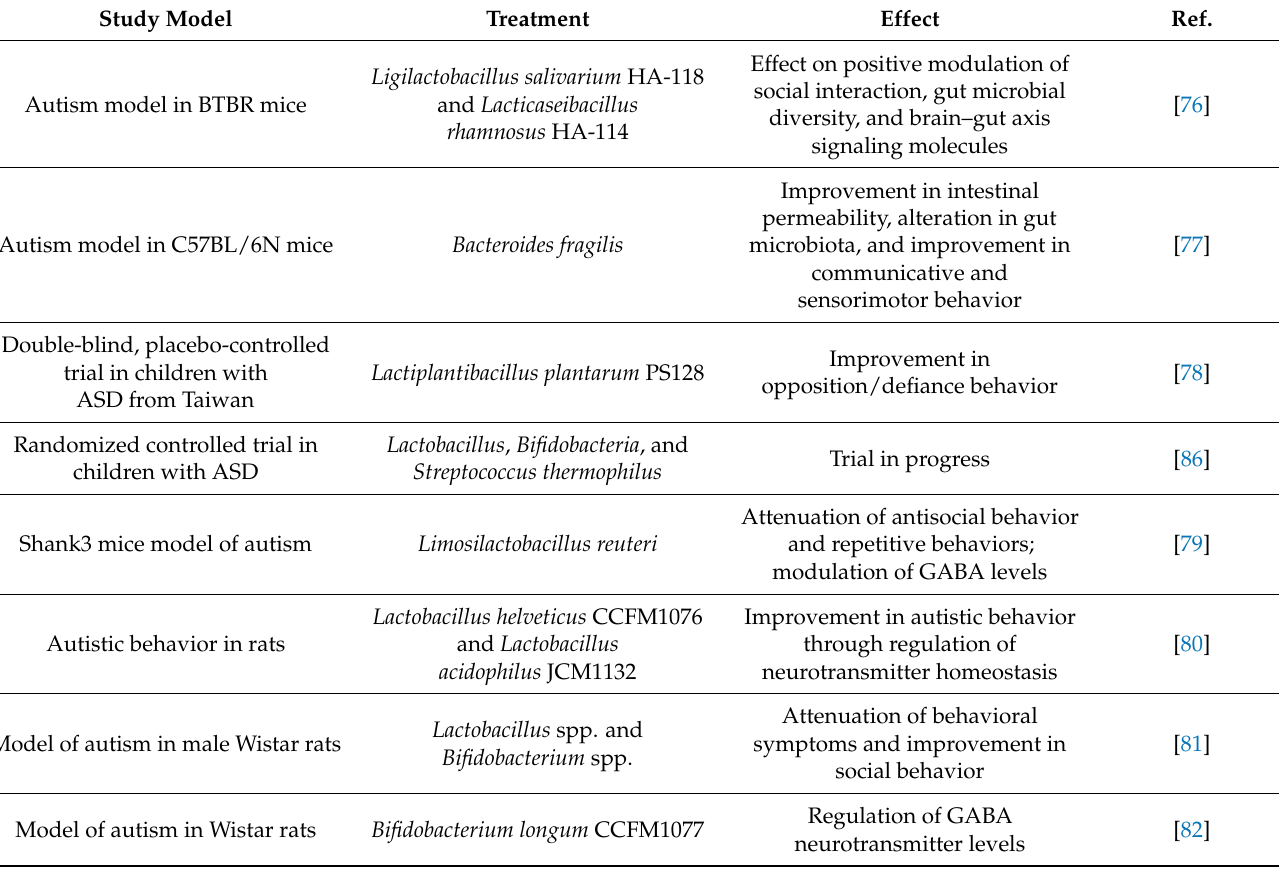
Table 1. Murine models and clinical trials on the use of probiotics in